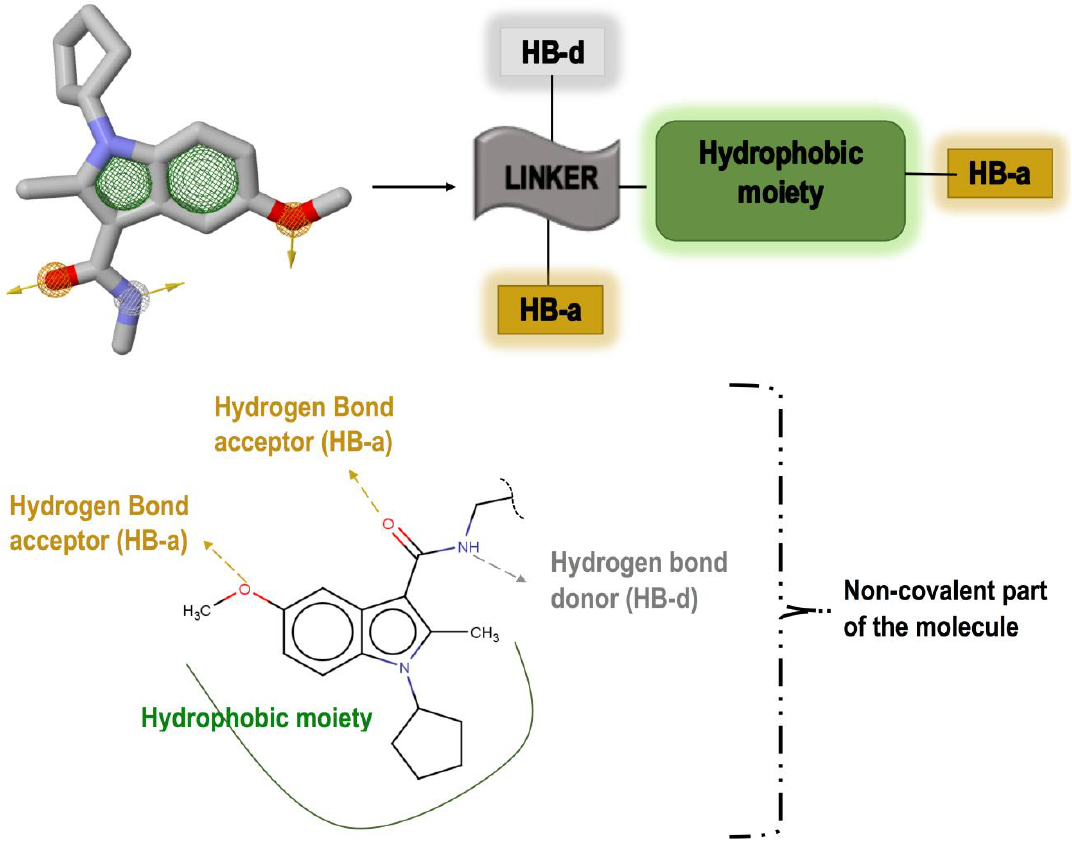
Figure 2. Important pharmacophoric features of the inhibitor’s non-covalent part and generation of a pharmacophore model based on these features.